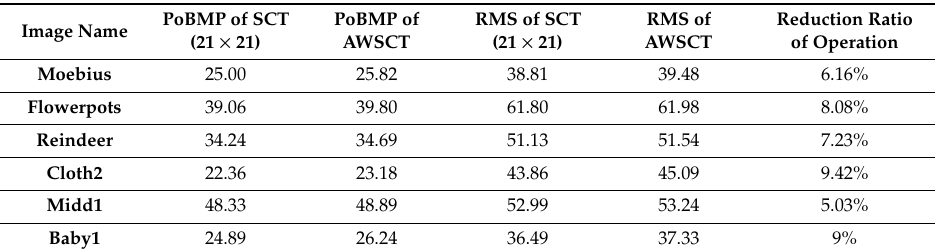
Table 3. Comparison of AWSCT and